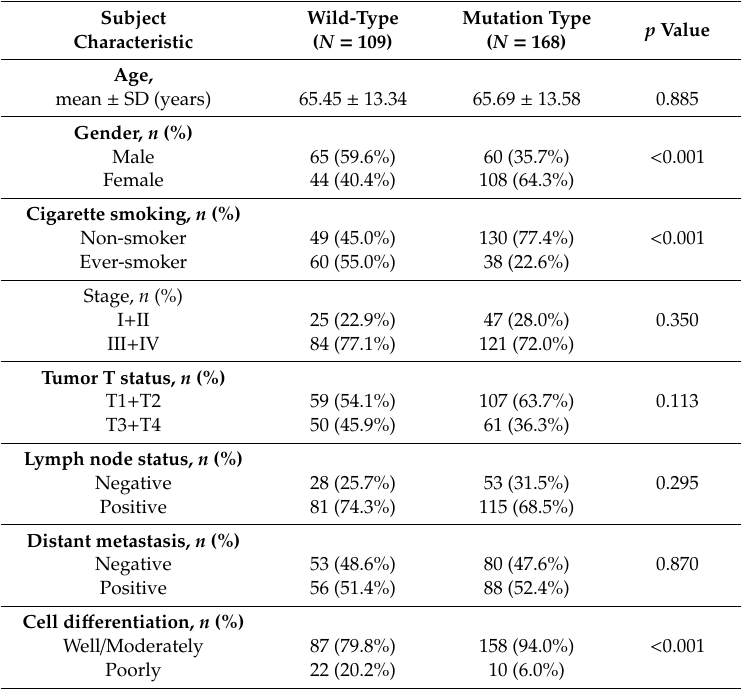
Table 1. Demographics and clinical characteristics of 277 lung adenocarcinoma patients with wild-type or mutant-type epidermal growth factor receptor